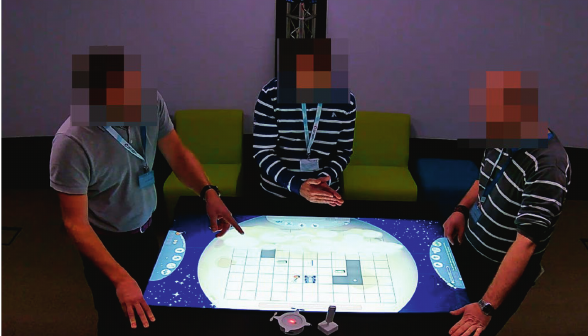
Figure 8: An example of “different problem” style (DP): P1 (left) of G3 is actively participating in his respective role’s control panel while, in parallel, P3 (right) is interacting with the system using the drone and P2 (middle) is not involved in either of these two ac- tivities. Their system interactions, gestures, or body postures relate to different